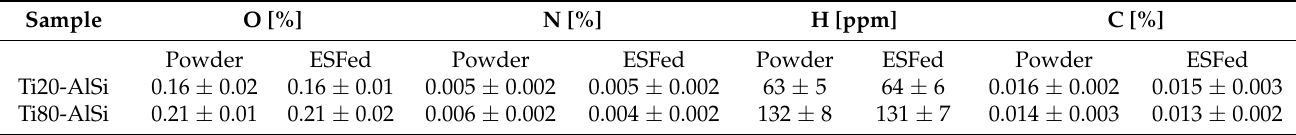
Table 1. Interstitial O, N, H, and C concentrations for powders and dense samples of Ti20-AlSi and Ti80-AlSi.